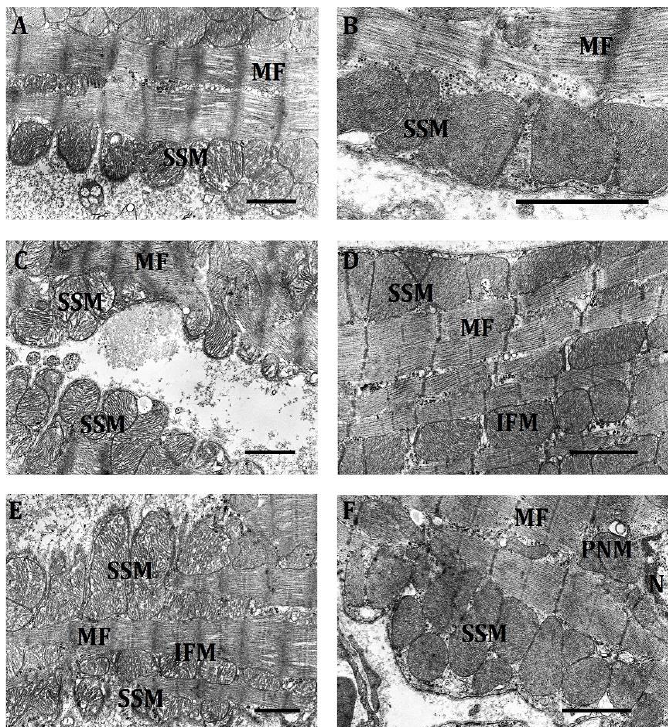
Figure 7. The ultrastructure of a subsarcolemmal region of a cardiomyocyte in rats with low ( A , C , E ) and high ( B , D , F ) resistance to oxygen deficit in mild (FiO 2 = 14%, ( A , B )), moderate (FiO 2 = 10%, ( C , D )) and severe (FiO 2 = 8%, ( E , F )) hypoxia. Tissue samples were taken 30 min after the start of the respective hypoxic training. SSM, subsarcolemmal mitochondria; MF, myofibrils. Scale bar, 0.5 μm .